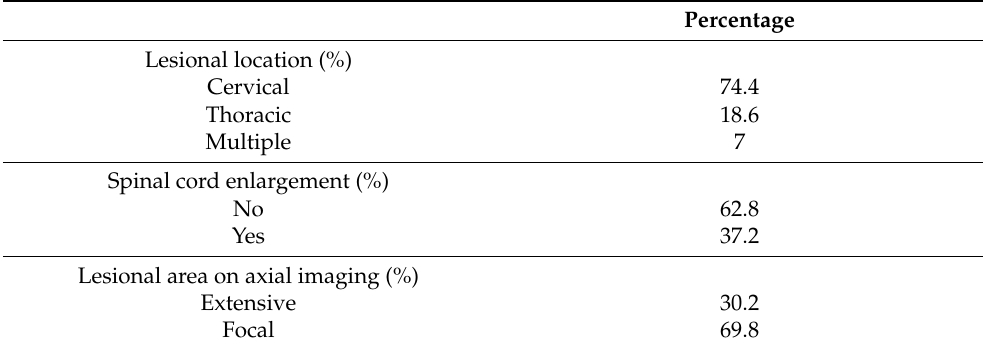
Table 2. MRI findings in 43 patients with non-neoplastic intramedullary